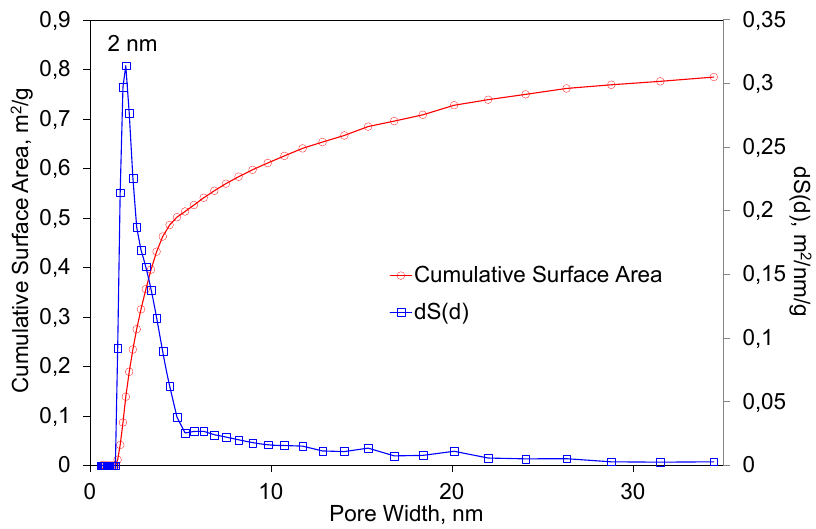
Figure 7. The dependence of the total surface area of the fibers on the pore diameter.